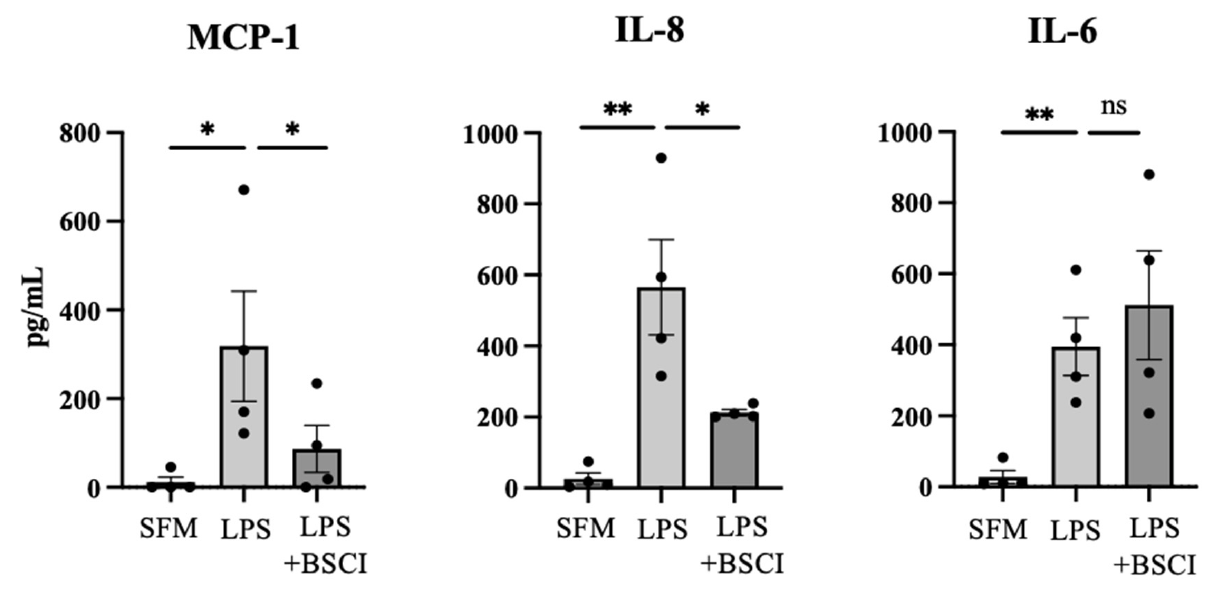
Figure 1. BSCI effect on infection-induced cytokine and chemokine secretion by human myometrial cells. Human cells isolated from myometrial biopsies of term pregnant women ( n = 4) were pretreated with BSCI (FX125L,250 nM) for 1 h followed by treatment with LPS (100 ng/mL) or vehicle (serum-free media, SFM) for 24 h. Cell culture media conditioned by primary myometrial cells were collected and analyzed by specific ELISAs. Bar graphs show concentrations of secreted MCP-1, IL-8, and IL-6 in pg/mL. Data are presented as mean ± SD; dots represent individual patient cell lines. Statistical significance was determined by one-way ANOVA followed by Dunnette’s multiple comparisons test. ‘*’ denotes statistical significance at p < 0.05, and ‘**’ at p < 0.01.